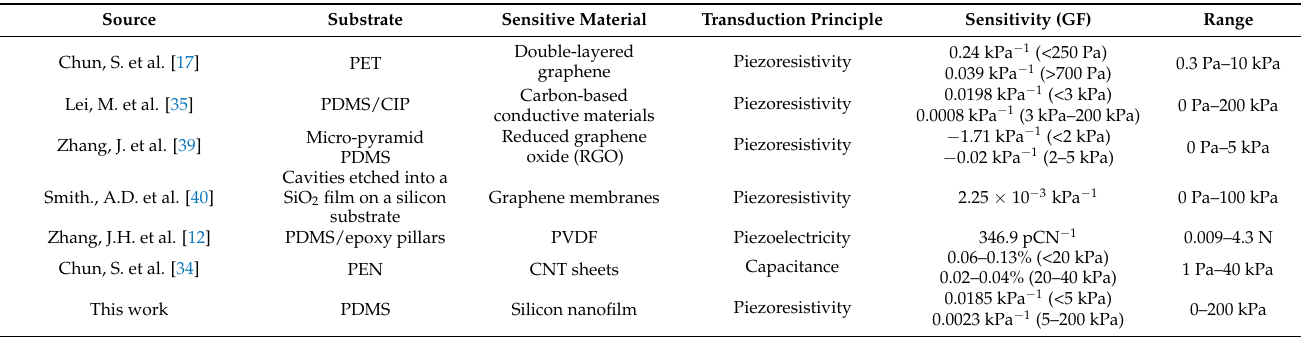
Table 2. Comparison of the fabricated flexible pressure sensor and existing pressure